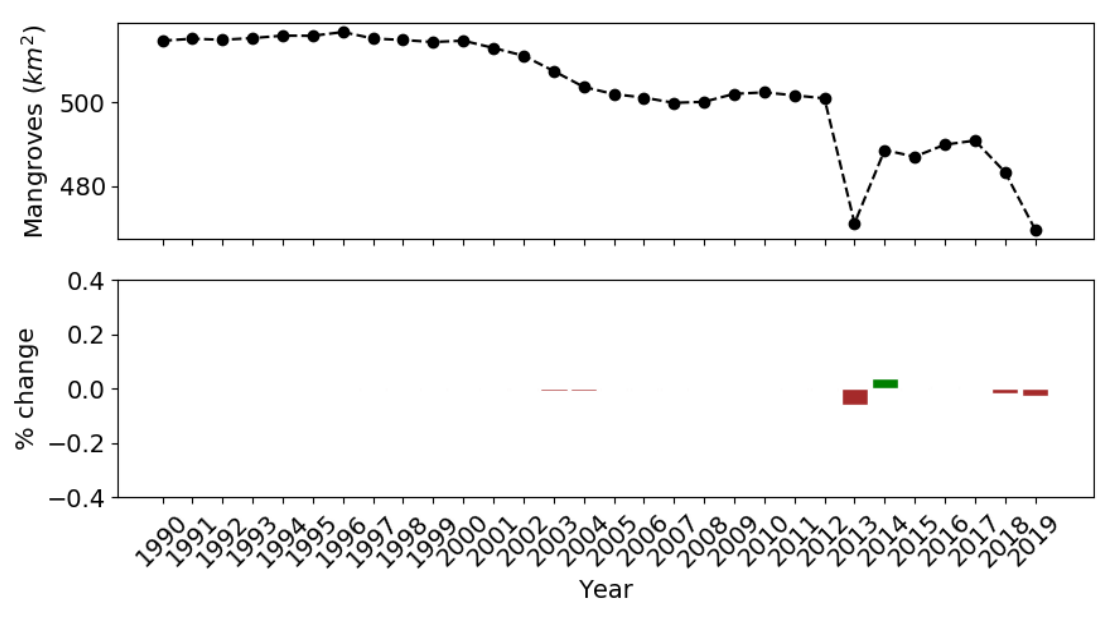
Figure 11. Mangrove extent over time for the Matang Forest Reserve, Malaysia.